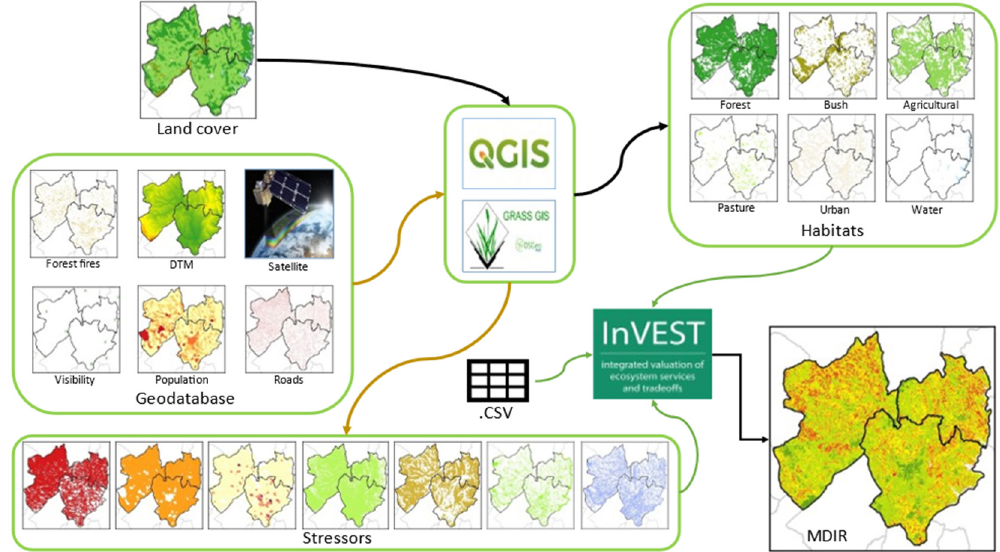
Figure 2. Modernized Dynamic Ignition Risk (MDIR) conceptual methodology.